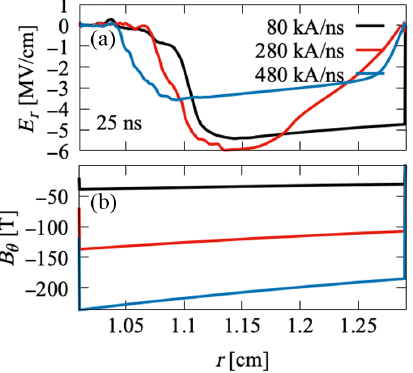
FIG. 7. (a) E r ð r Þ averaged from z ¼ 0 . 3 – 1 . 0 cm at 25 ns for the simulations in Fig. 5. Without particles, E r is constant across the gap and zero at the electrodes, similar to the 80 kA = ns trace at r ¼ 1 . 3 cm which is before the anode plasma forms. The voltage drops are 990, 870, and 755 kV for 80, 280, and 480 kA = ns, respectively. (b) B θ ð r Þ at 25 ns. Note, the electrodes are perfect electric conductors in these kinetic simulations (Dirichlet boun- dary conditions).